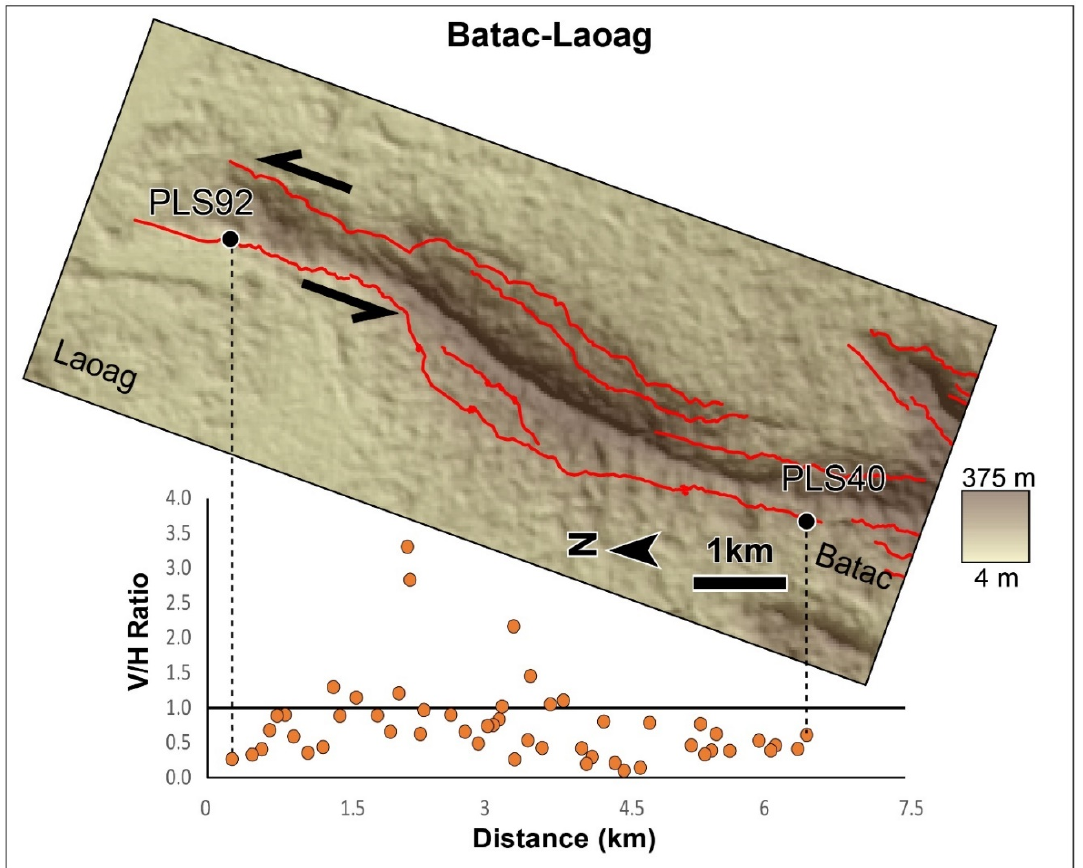
Figure 9. Map of the trace from Batac to Laoag (labeled ‘e’ in Figure 2A) above the offset plot for this part of the Vigan-Aggao Fault. The fault zone is also marked, at a smaller scale, by a bend within a right-step gap.